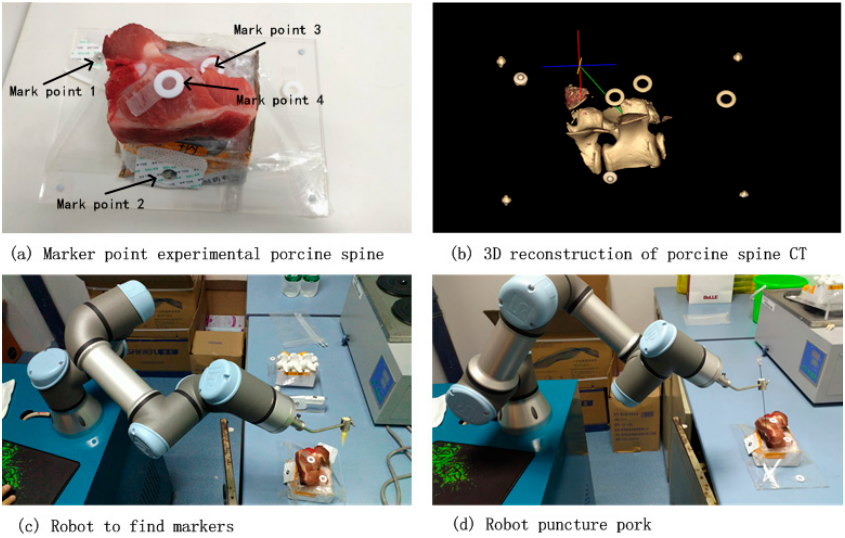
Figure 14. UR3 robot puncture process chart.